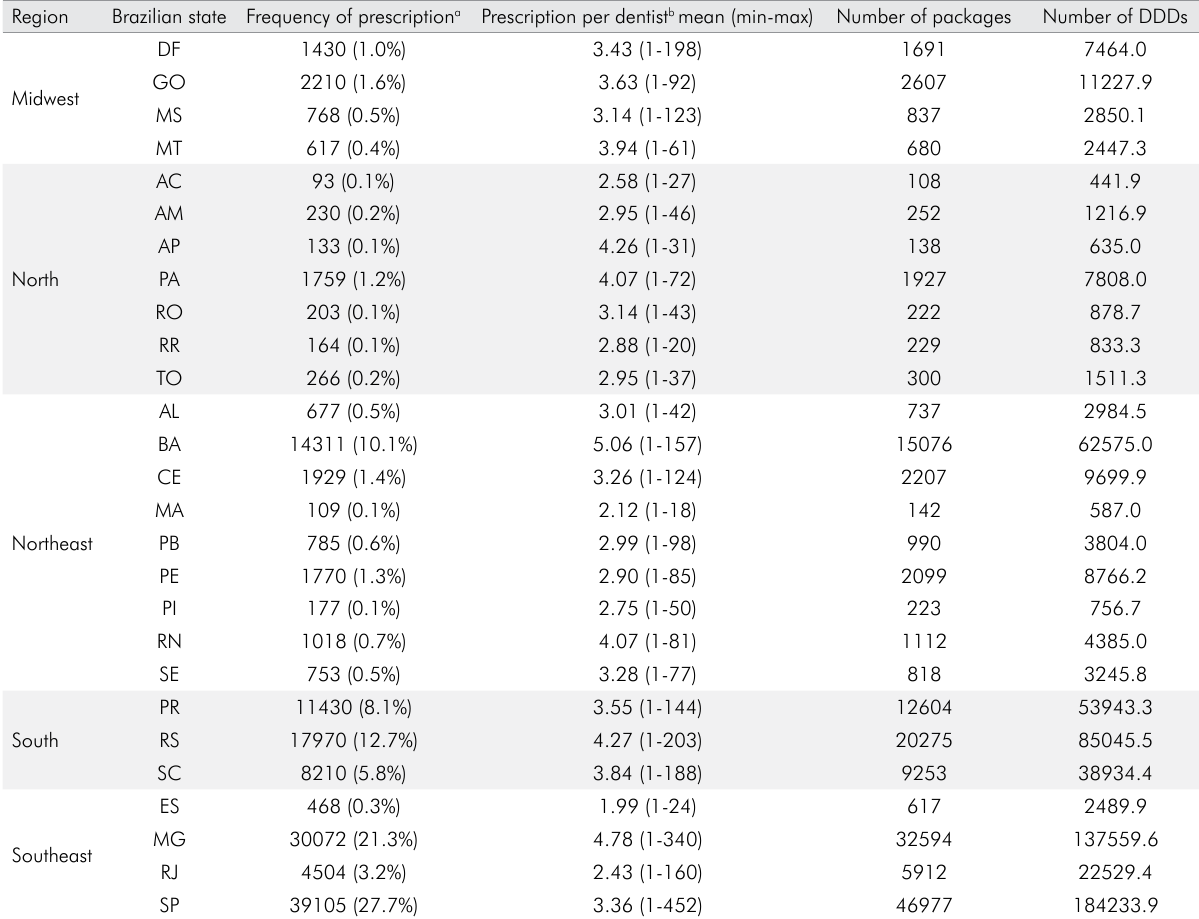
Table 2. Descriptive statistics on the opioid analgesics prescribed by Brazilian dentists dispensed by Brazilian state in 2012.